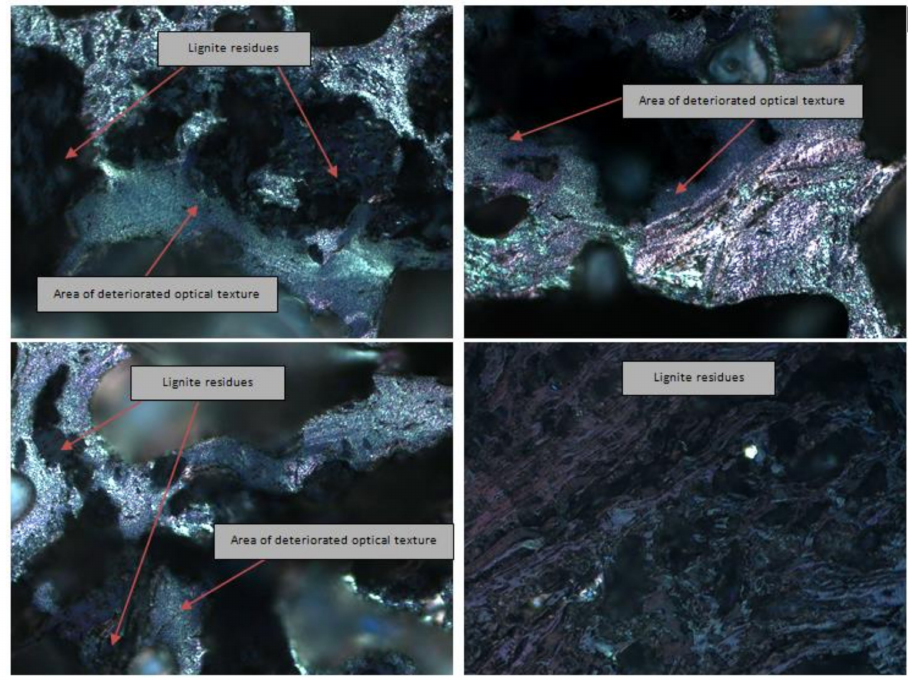
Figure 9. Exemplary photomicrographs of lignite residues in